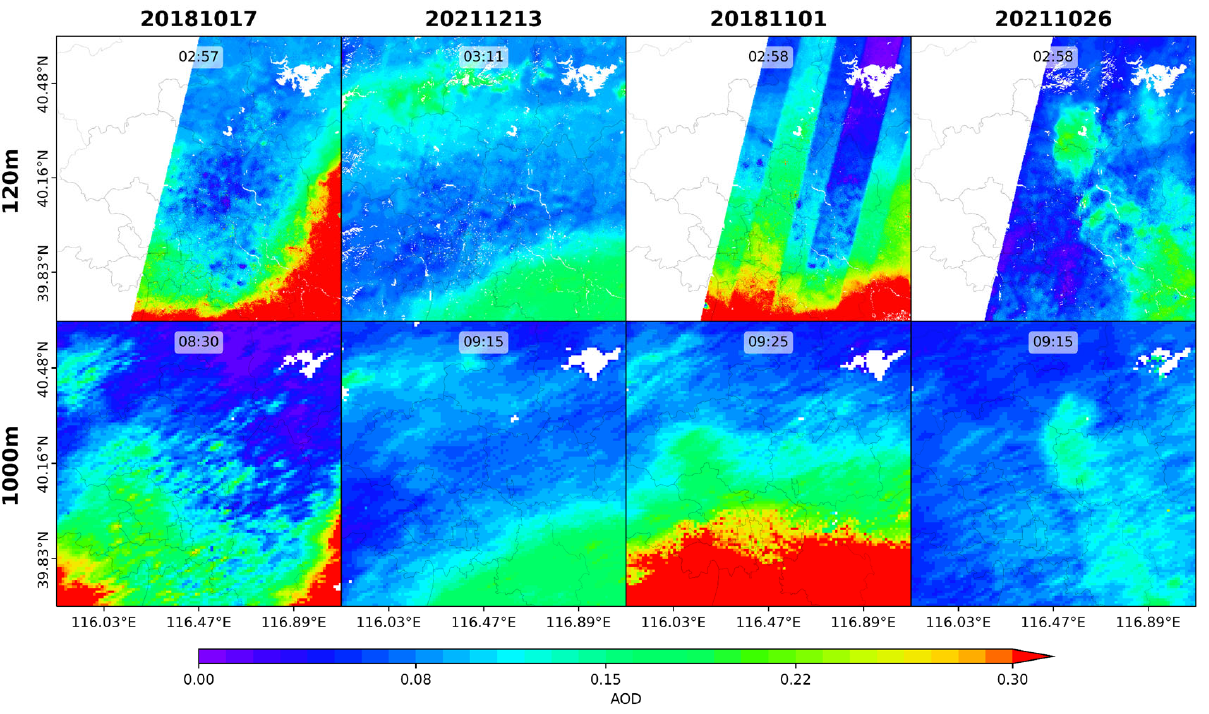
Figure 5. Low-value AOD spatial distributions of the proposed algorithm (the first row) and MODIS MAIAC (the second row) in four retrieval days (UTC).